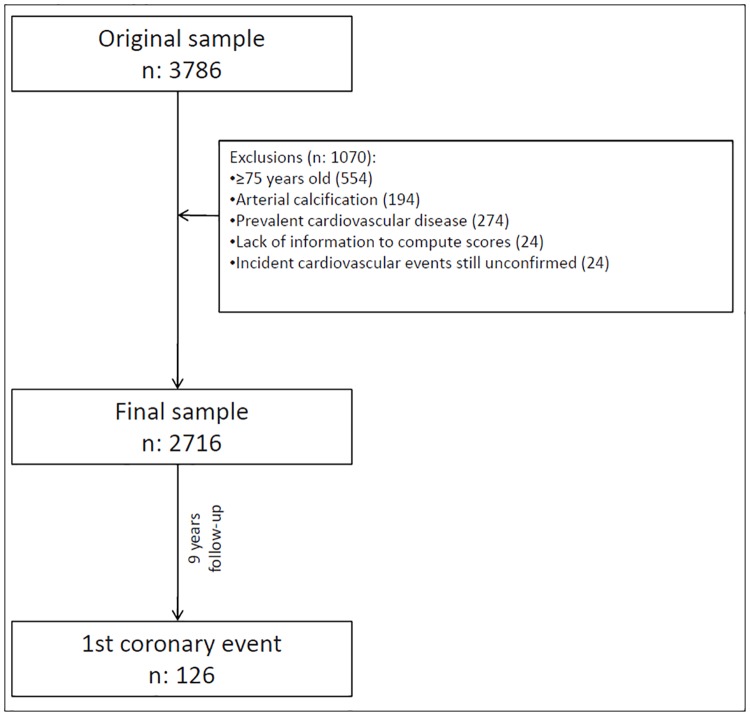
Study flow-chart.